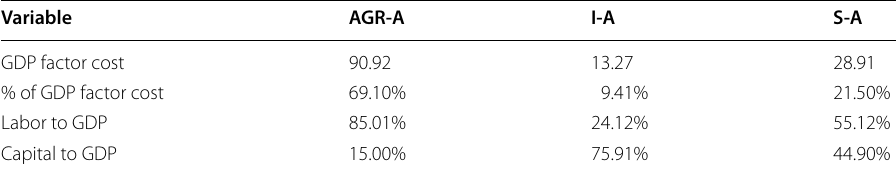
Table 6 Value added at factor costs in billion ETB. Source: author’s computation using GAMS